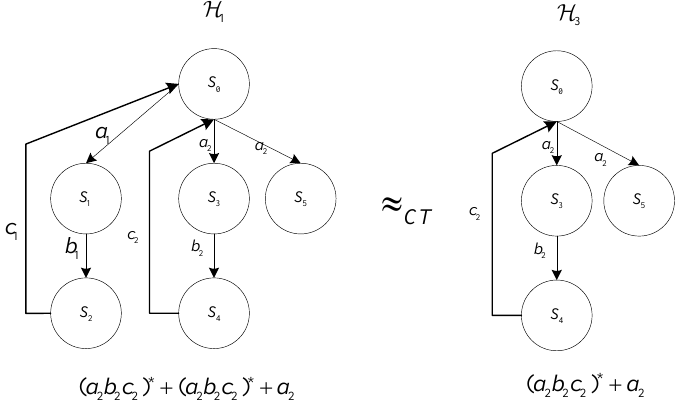
Figure 6. An approximate completed trace equivalence